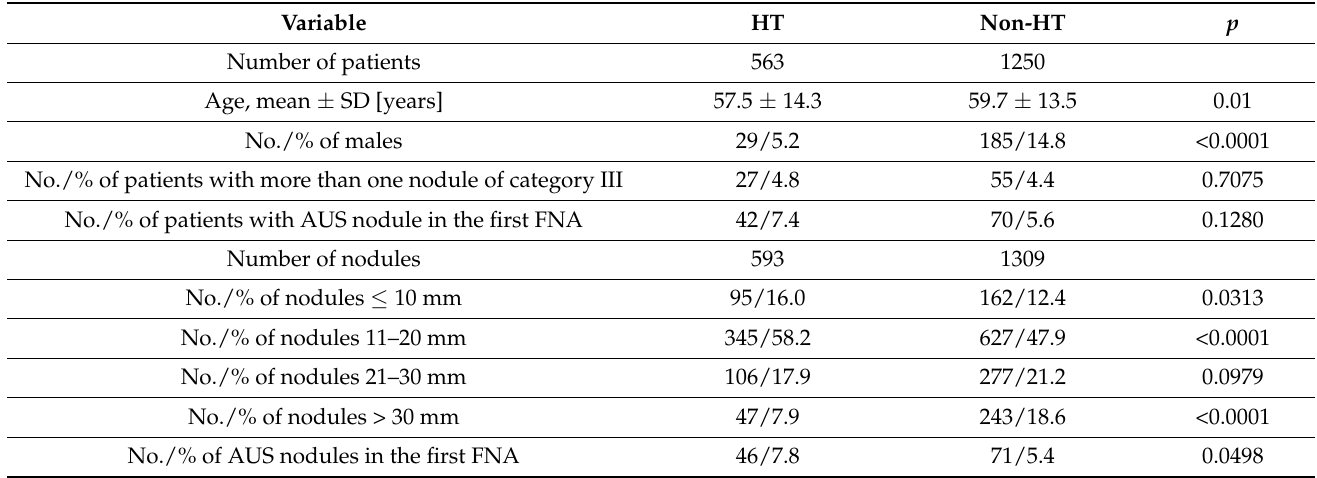
Table 1. Demographic data of the patients and distribution of nodules’ sizes in the HT and non- HT